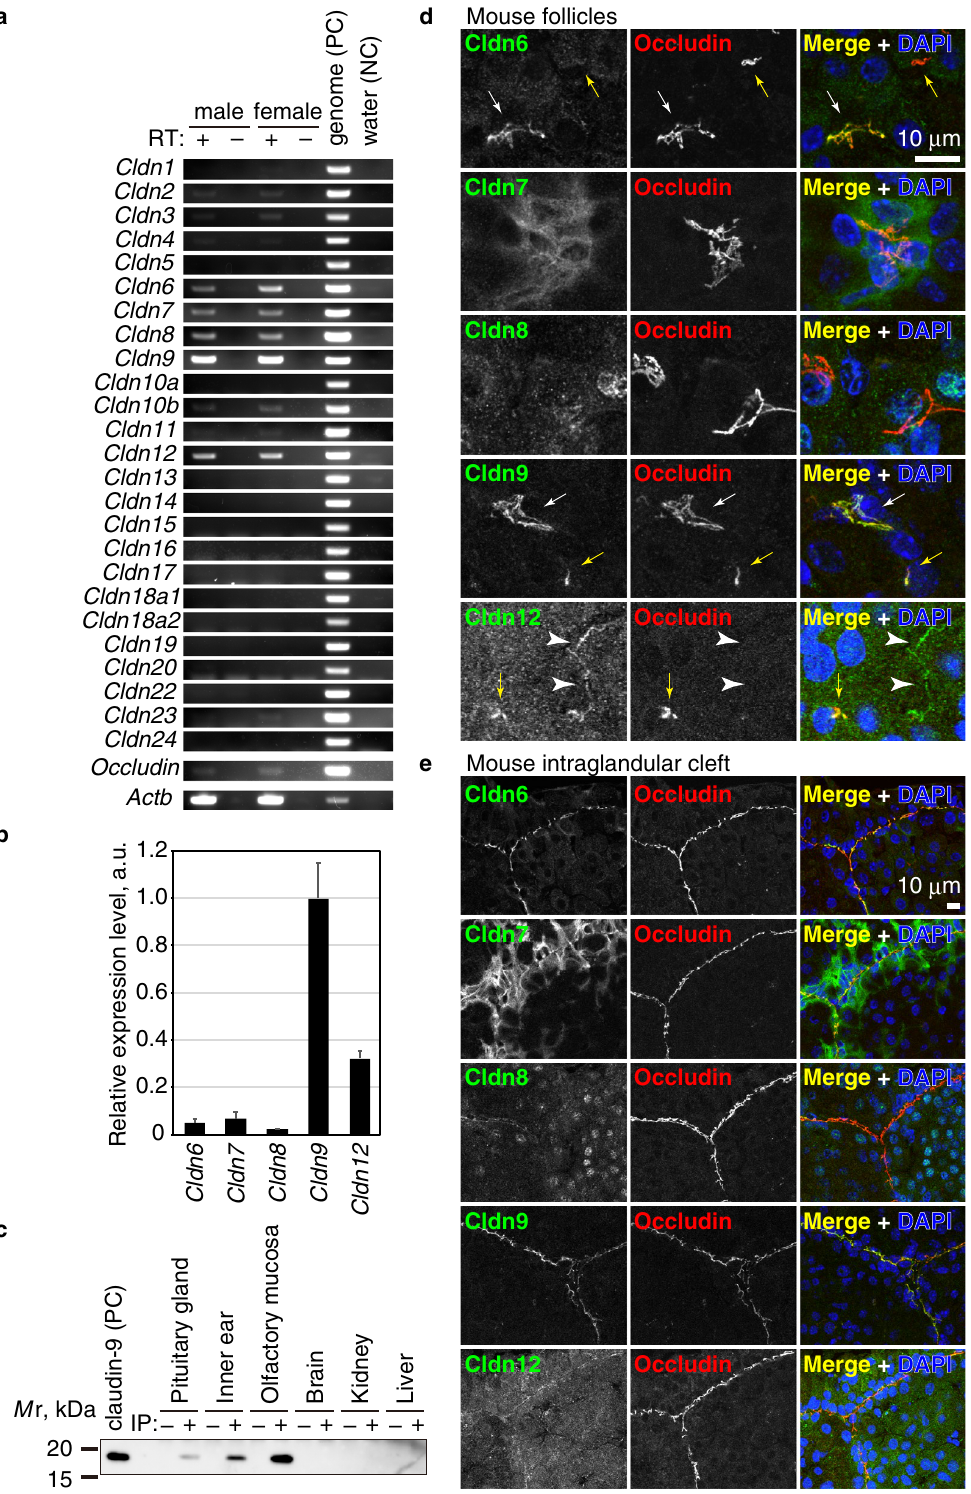
Figure 3. Claudin-9 is a component of FS cells. ( a ) RT-PCR of the pituitary gland of adult male and female mice. Since the forward and reverse primers were designed in the same exon, the genome DNA was used as a positive control (PC) and water was used as a negative control (NC). The reaction mix without reverse transcriptase (RT) also served as a negative control. ( b ) Real-time RT-PCR of the adult mouse pituitary gland. The expression levels were normalized using known concentration of DNA fragments as standards. The expression level of cldn9 was set to 1. Error bars indicate s.d. ( c ) Immunoprecipitation of claudin-9 from adult mouse organs using rat anti-claudin-9 (clone 1B1) and immunoblotting using goat anti-claudin-9 pAb. Human CLDN9-expressing HEK293T cell lysate served as a positive control (PC). Note that the claudin-9 band was detected in the pituitary gland lysate as well as in the inner ear and olfactory mucosa. ( d ), ( e ) Immunostaining of the adult mouse anterior pituitary gland using anti-claudin-6 pAb, anti-claudin-7 pAb, anti-claudin-8 pAb, anti-claudin-9 mAb (clone 1B1), or anti-claudin-12 pAb together with anti-occludin mAb or pAb and